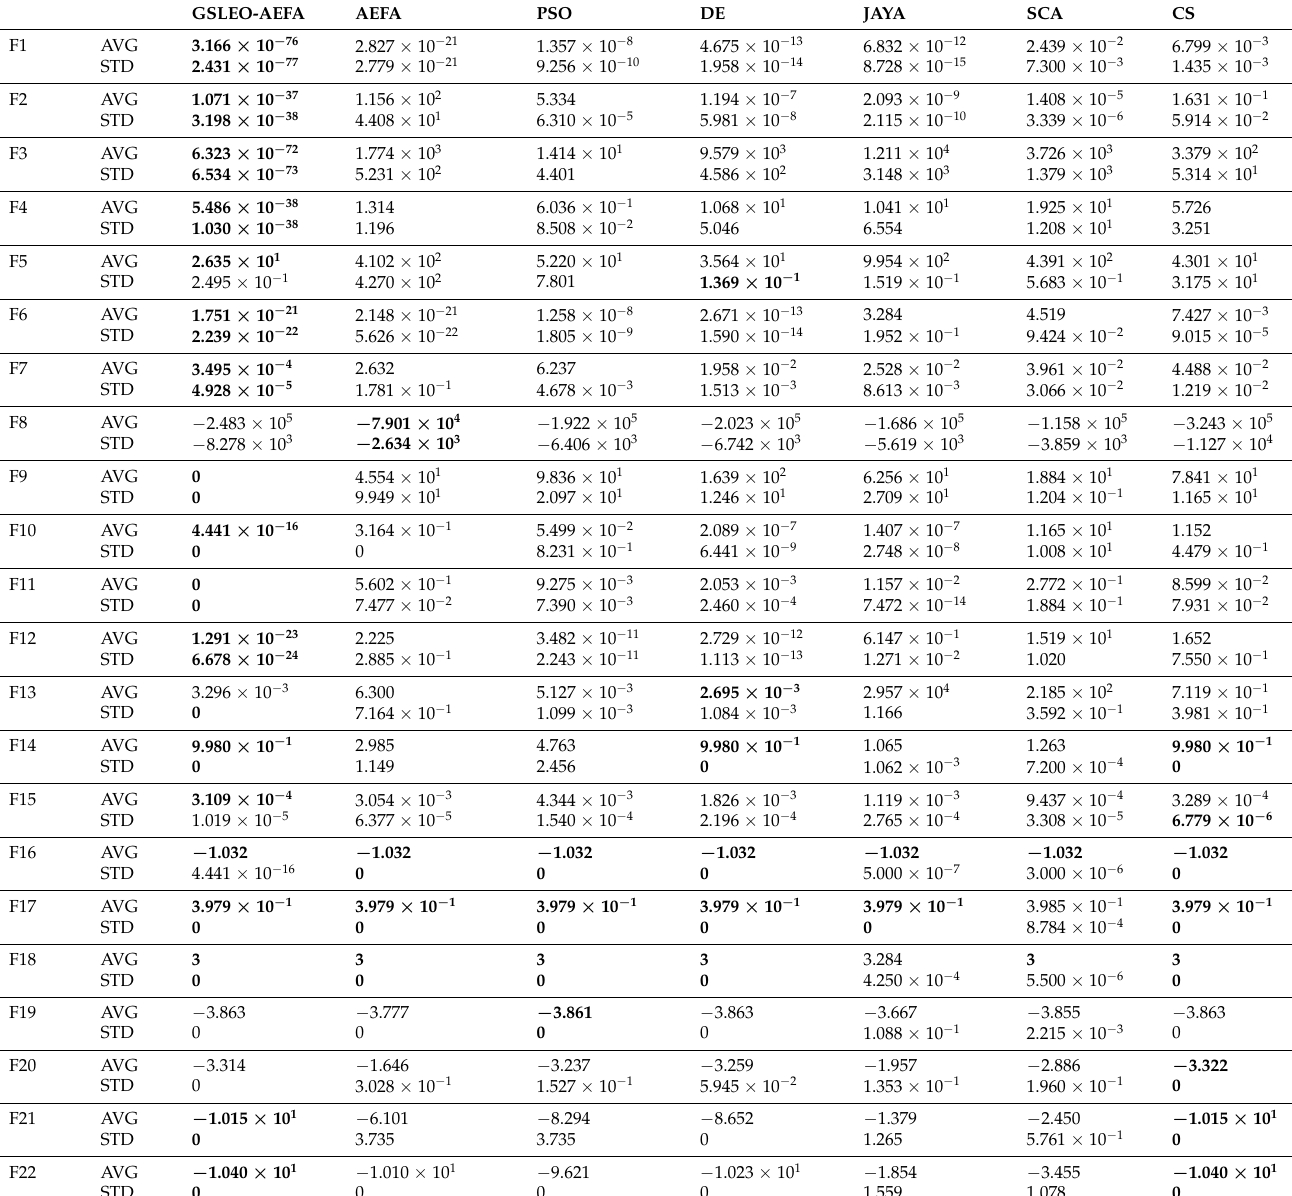
Table 3. F1-F23 Comparison with dimension = 30, significant values are in